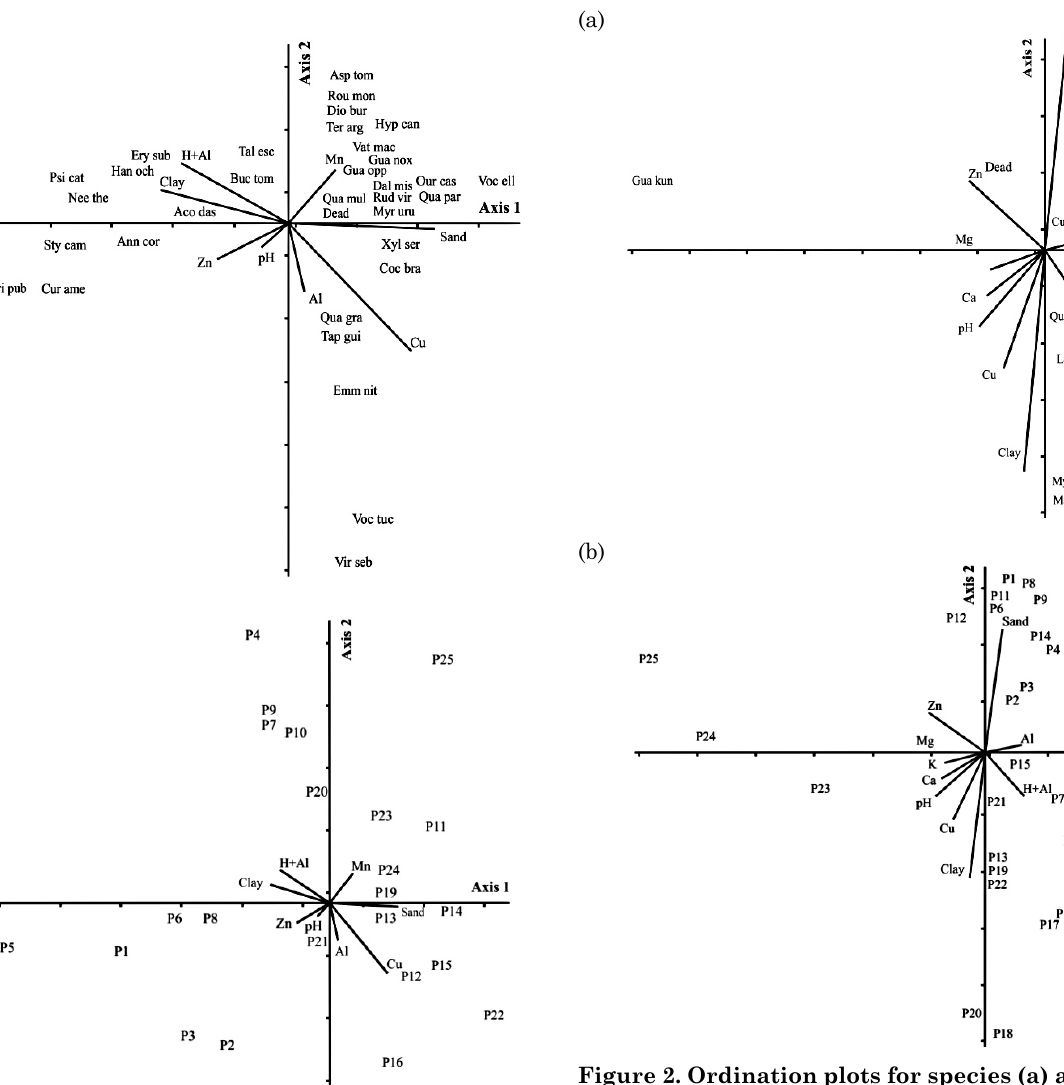
Figure 2. Ordination plots for species (a) and plots (b) resulting from canonical correspondence analysis based on the density distribution of 13 tree and shrub species represented by at least 15 or more plants in the cerrado of Montes Claros Goiás. Edaphic variables are represented by the following vectors: h+al: potential acidity, cu: copper, al: